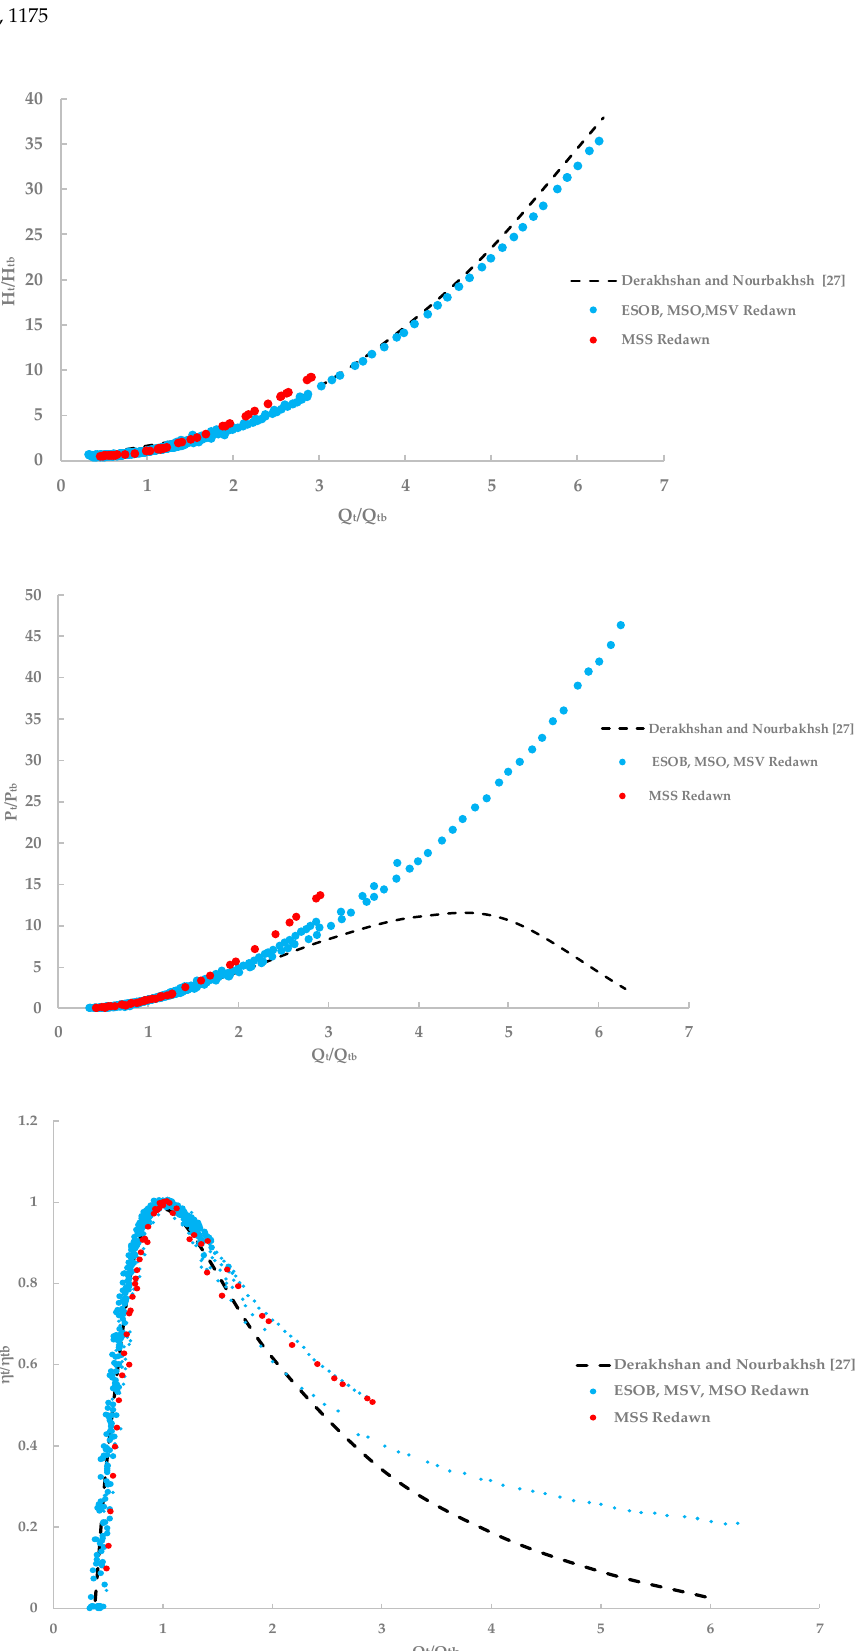
Figure 8. Comparison between the Redawn experimental data and the Derakhshan and Nourbakhsh [27] model in terms of; head-discharge ( upper panel), power-discharge ( central panel) and efficiency- discharge ( lower panel).